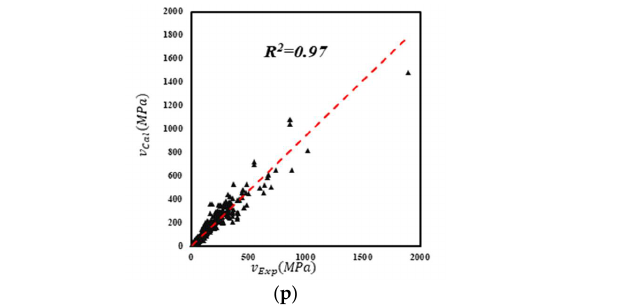
Figure 7. Comparison of proposed model with existing models: ( a ) Greenough and Nehdi [17], ( b ) Kunita et al. [27], ( c ) Shin et al. [46], ( d ) Sharma et al.[12], ( e ) Imam et al.[47], ( f ) Ashour et al.[48], ( g ) Kwak et al.[13], ( h ) Narayanan and Darwish [49], ( i ) Shahnewaz and Alam [18], ( j ) Shahnewaz amd Alam[51], ( k ) RILEM[52], ( l ) Gandomi et al [50]., ( m ) Sarveghadi et al [16]., ( n ) Chaabene and Nehdi 2021 [53], ( o ) Sabetifar et al.[22], ( p ) Proposed model.